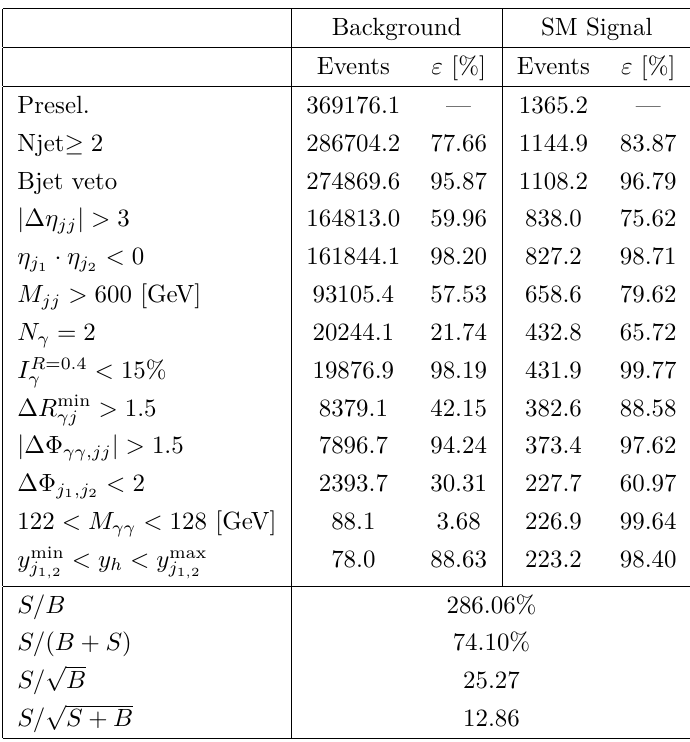
Table 5 . Cut-flow for diphoton channel presented. Both background and signal samples separated in to two columns where on the left of each one yielding number of events are presented at 0.3 ab − 1 and the right column shows the relative efficiency of each cut. At the bottom part certain ratios are presented. Note that what’s referred to as signal ( S ) here is the SM VBF. In the final analysis, the SM VBF is part of the